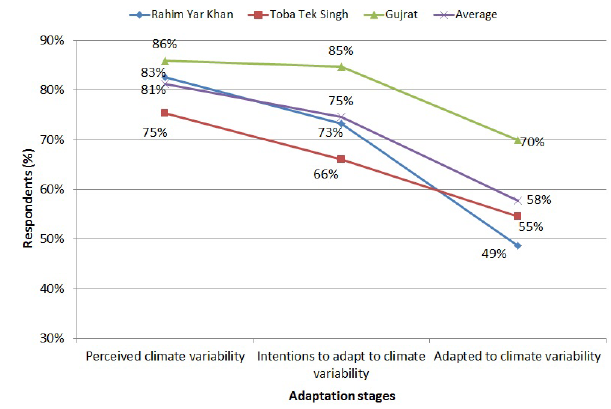
Figure 4. Perceptions, intentions and adaptation to climate change across different study